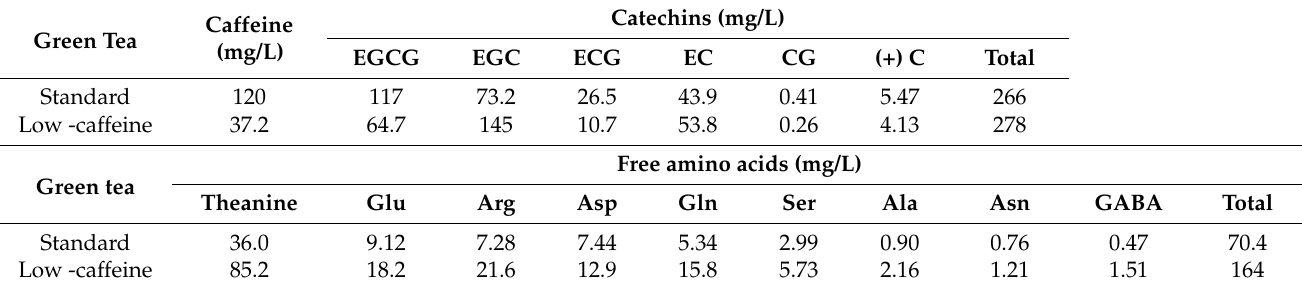
Table 2. The content of caffeine, catechins, and amino acids in a solution of green